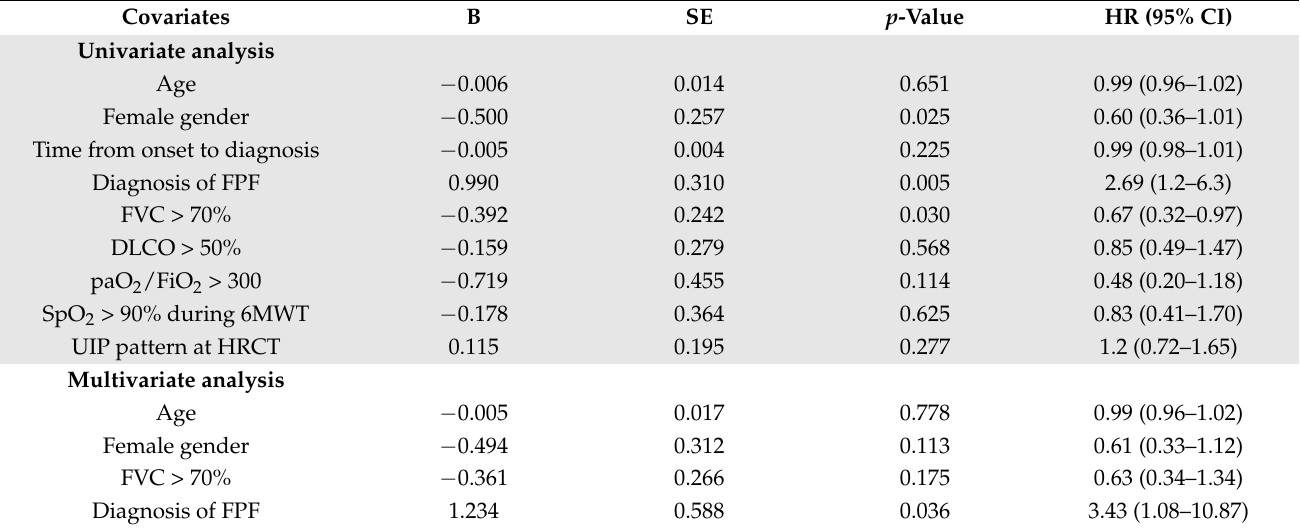
Figure 3. Comparison of progression-free survival among subjects with IPF ( red line ), FPF ( blue line ) and PF-ILD ( green line ), expressed with Kaplan–Meier curves. Table 3. Univariate and multivariate analysis for progression-free survival in the entire study